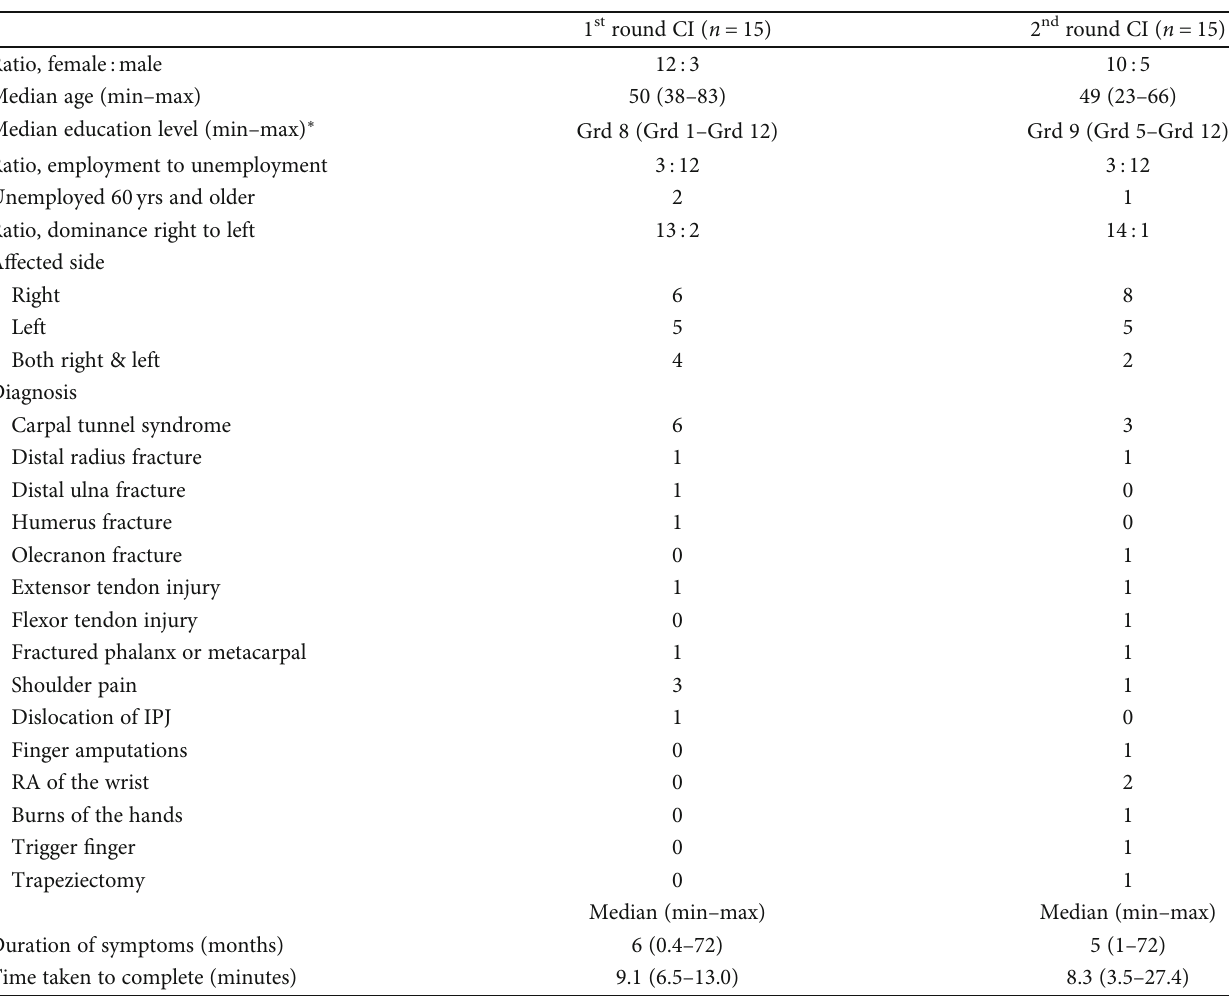
Figure 1: Iterative process followed during cognitive interviewing. Table 3: Patient